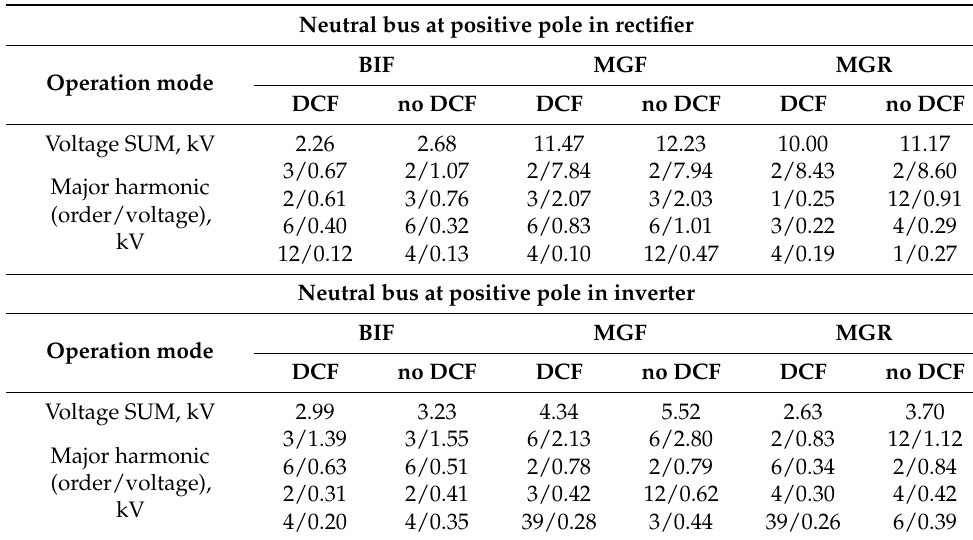
Table 5. Harmonic voltage stress for the NBC.